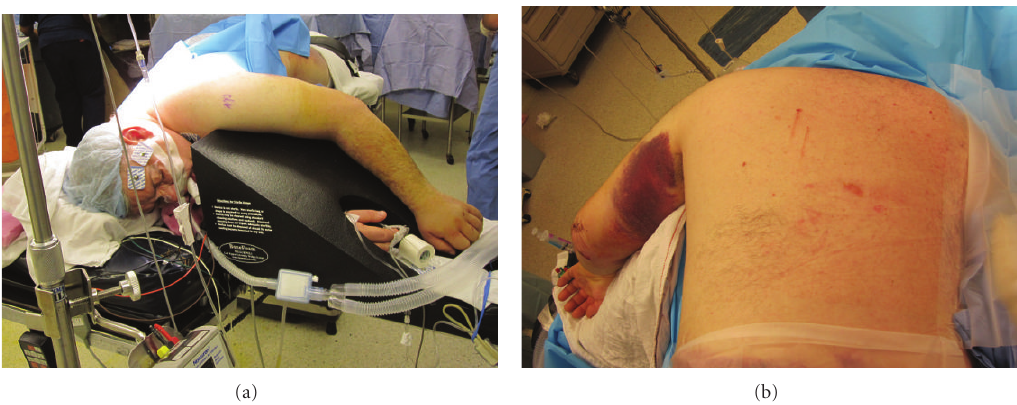
Figure 5: The patient is positioned in lateral decubitus on a beanbag with the operative arm in the prone